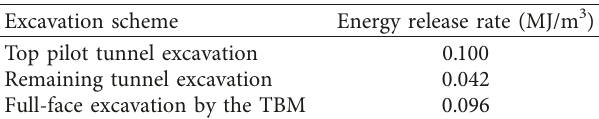
Figure 14: On-site photos showing moderate rockburst damage (taken on 6 July, 2010). Table 3: Energy release rates of different excavation steps of the headrace tunnel